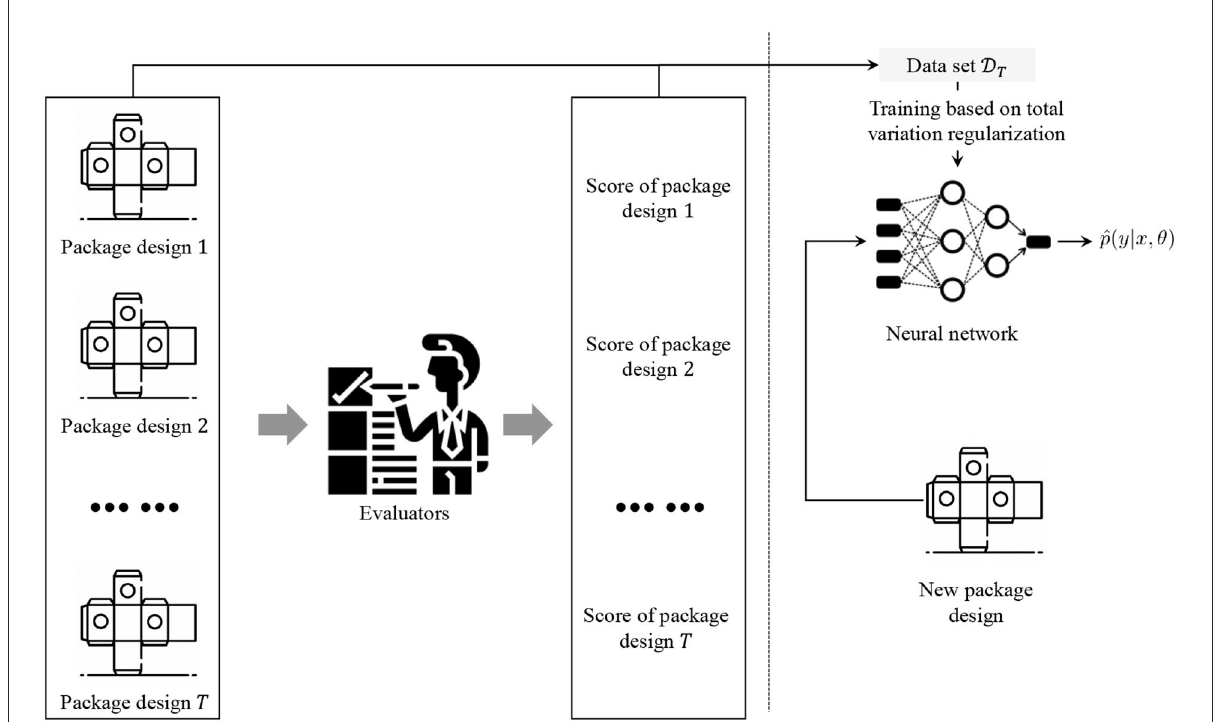
FIGURE3 Process of implementation of the proposed robust robot classification for evaluating package